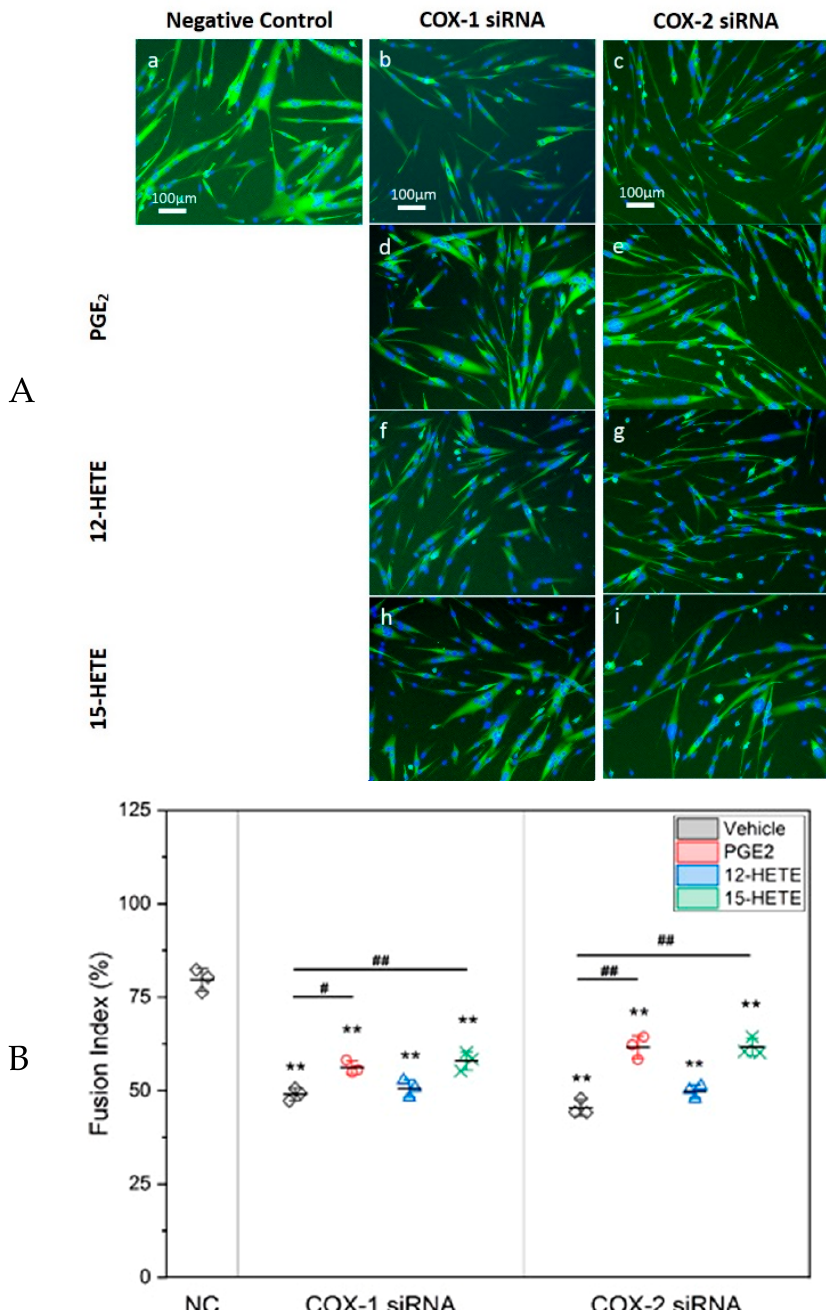
Figure 4. Treatment with PGE 2 or 15-HETE partially recovers the impaired myogenesis induced by COX-1 or -2 knockdown. Panel A : Representative fluorescence images of morphological changes of myotubes after siRNA transfection and supplement with LMs. Blue: DAPI (4 ′ ,6-diamidino-2- phenylindole) staining; green: MHC (myosin heavy chain) staining. Panel B : Pretreatment with PGE 2 and 15-HETE partially but significantly improved Fusion Index. n = 3, ** p < 0.01 compared with NC; # p < 0.05 and ## p < 0.01 compared with COX-1 or -2 siRNA. 2.5. Results of Lipidomic Analysis of C2C12 Cells Show Similar Patterns as Primary Myoblasts